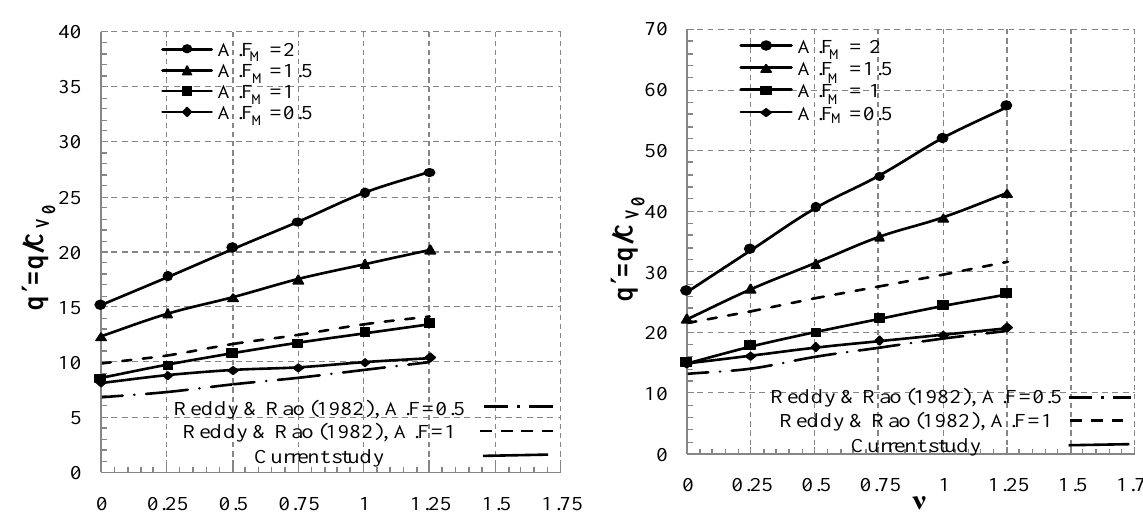
Fig. 5. Variation of q with ν for different A.F